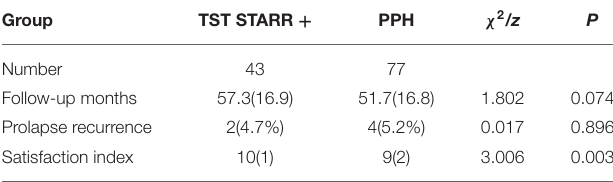
TABLE 4 | Long term